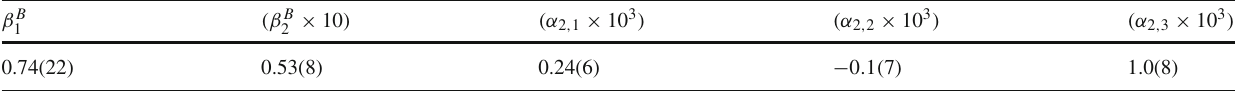
dom and the best-fit gives χ 2 / dof = 3 . 7. The LECs β B are given in units of GeV, GeV − 1 and GeV − 4 ,